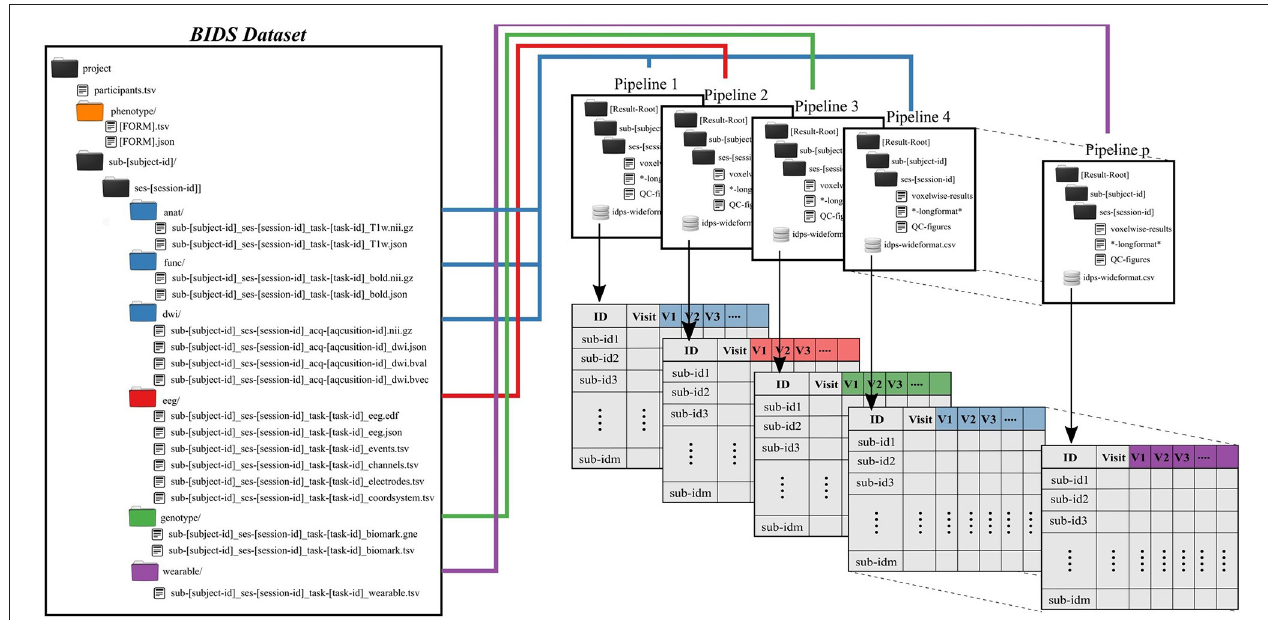
FIGURE 2 | Preprocessing pipelines operate on BIDS-formatted inputs and create output in tabulated form for group level analysis. Derived data are colored to match raw data